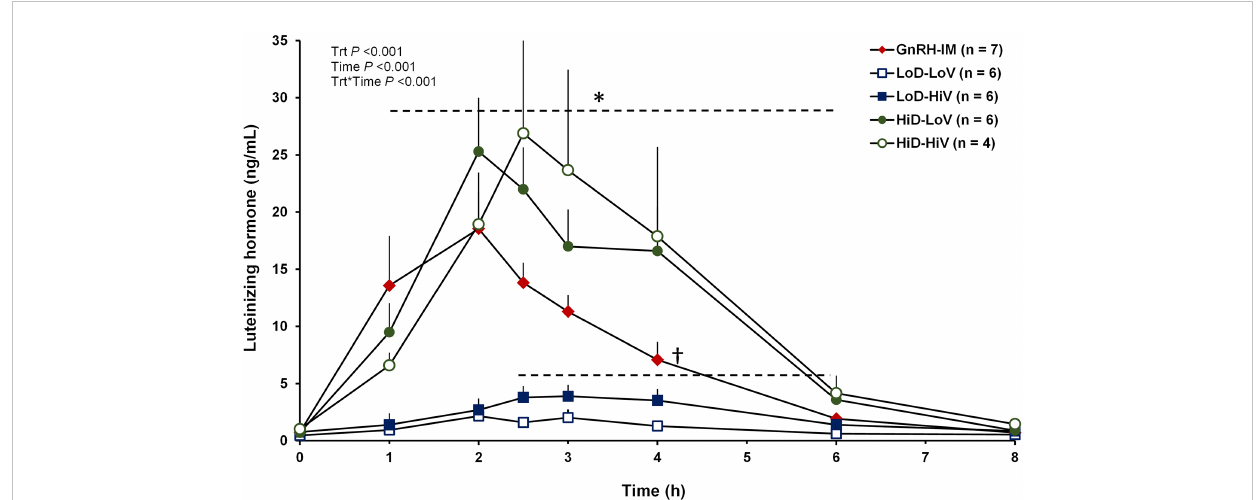
FIGURE 3 Circulating concentrations of luteinizing hormone (LH) from 0 to 8 h after treatment for cows in experiment 2. At 48 h after induction of luteolysis, lactating Holstein cows were randomly assigned to receive 100 µg of Gonadorelin in 2 mL of solution by intramuscular injection (GnRH-IM; n = 7), 100 µg of Gonadorelin in 2 mL (LoD-LoV; n = 6), 100 µg of Gonadorelin in 10 mL (LoD-HiV; n = 6), 1,000 µg of Gonadorelin in 2 mL (HiD-LoV; n, 6), or 1,000 µg of Gonadorelin in 10 mL (HiD-HiV; n = 4) with the e-Synch device. Blood was collected at 0, 1, 2, 2.5, 3, 4, 6 and 8 h after treatment. Mean circulating concentrations of LH were affected by treatment ( P < 0.001), time ( P < 0.001), and the treatment by time interaction ( P < 0.001). *HiD-Lov, HiD-HiV, and GnRH-IM were greater ( P < 0.05) than the LoD-LoV and LoD-HiV treatments, based on the LSD post-hoc mean separation test. † LoD-HiV was greater ( P < 0.05) than the LoD-LoV treatment, based on the LSD post-hoc mean separation test. Other differences described in the text. Trt,